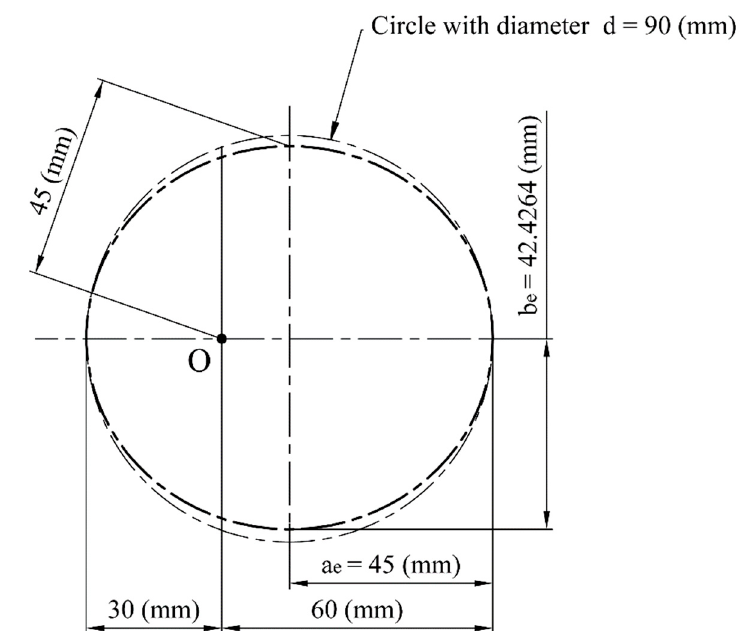
Figure 4. Dimensions of the designed pitch ellipse.